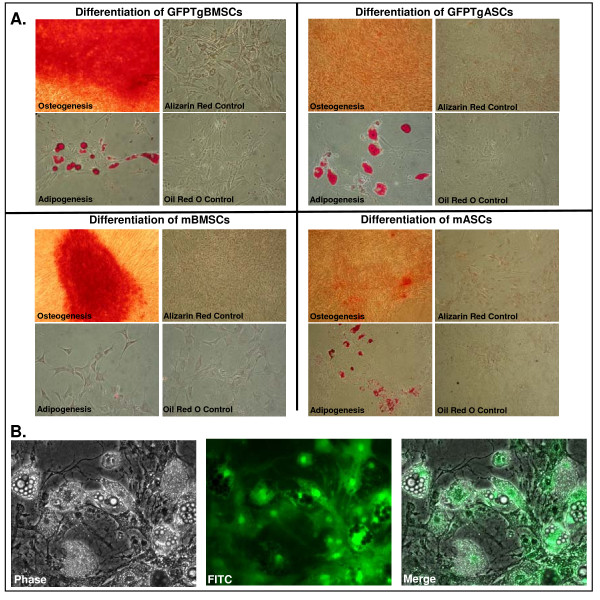
A. Differentiation of mMSCs and GFPTgMSCs along mesodermal lineages. Cells were incubated in CEM and then transferred to adipogenic or osteogenic media for 14 days. All cells were passage 9 or lower. Cells which formed lipid vacuoles were stained with Oil Red-O while mineralization in osteogenic-differentiated cells was revealed with Alizarin Red staining.B. GFPTgMSCs retain fluorescence after differentiation. MSCs derived from eGFP+ transgenic C57Bl/6 mice (P6) retain fluorescence even after stimulated to undergo adipogenic differentiation. 20× magnification.